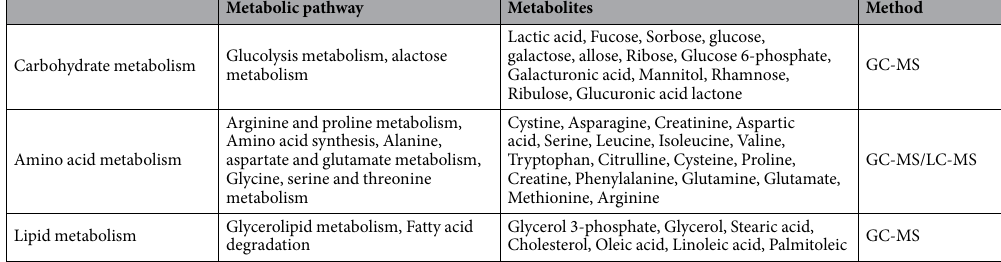
biomarkers that may reflect the sows’ metabolic status and the piglets’ nutritional requirements, P -value and variable importance in projection (VIP) values calculated by PLS-DA assay were considered at the same time (Table 3). In colostrum, glucuronic acid lactone, mannitol, inositol, inositol, histamine, and allantoin showed sig- nificant differences between the two groups (P < 0.05). In mature milk, the level of creatine, glutamate, glutamine, 4-hydroxyproline, alanine, asparagine, and glycine were significantly higher in the HL group ( P < 0.05), while the levels of arginine and cholesterol were lower in the HL group ( P < 0.05) (Table 3).